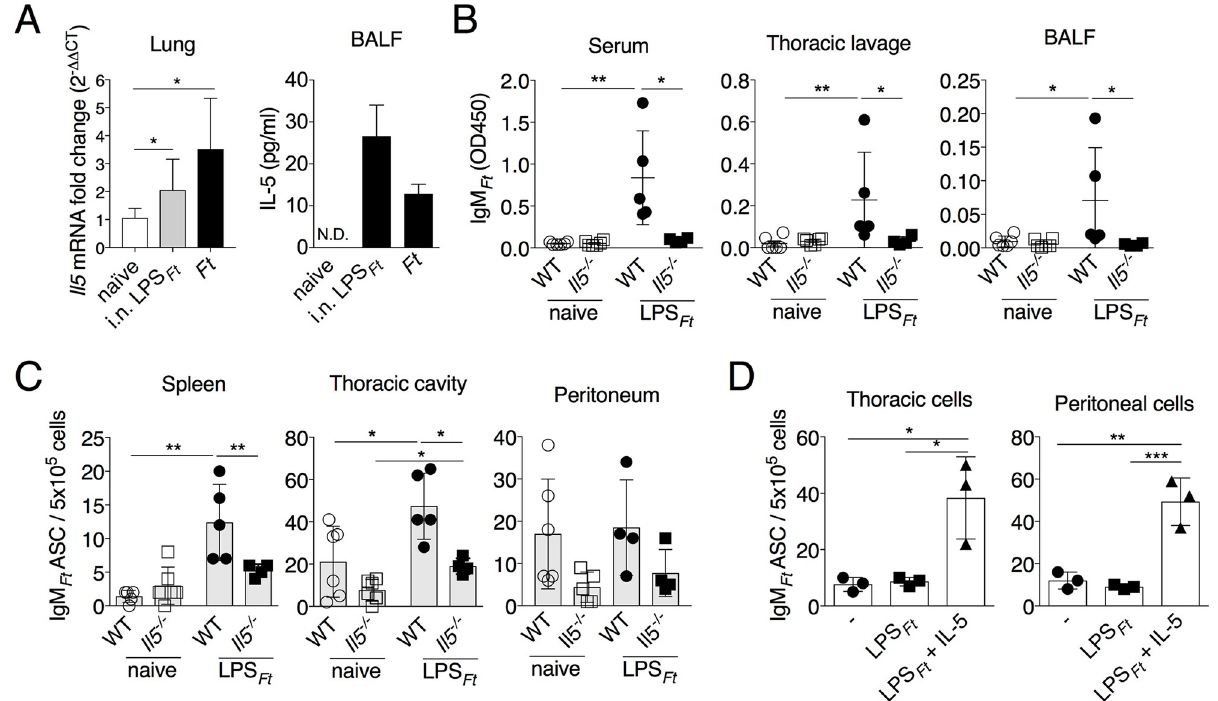
Fig 3. IL-5 promotes IgM production by B1 cells. (A) WT B6 mice (n = 3–8) were immunized i.n. with LPS Ft i. Il5 mRNA was measure in total lung RNA by RT-PCR and IL-5 protein in BALF by ELISA. (B, C) WT B6 or Il5 -/- mice were immunized with LPS Ft . Seven days post-immunization IgM was measured in serum, BALF, or thoracic cavity lavage and IgM Ft purified from peritoneal or thoracic cavity of i.n. immunized WT B6 mice (day 7) were cultured in vitro with LPS Ft in presence or absence of IL-5 for 2 days and then used to seed ELISPOT assay. One representative experiment of three (A) or two (B-D) is shown. Data are expressed as mean ± SD. A-C, Mann-Whitney U test; D, one-way ANOVA Tukey Post-test. � p < 0.05, �� p < 0.01, ��� p < 0.001. See also S3